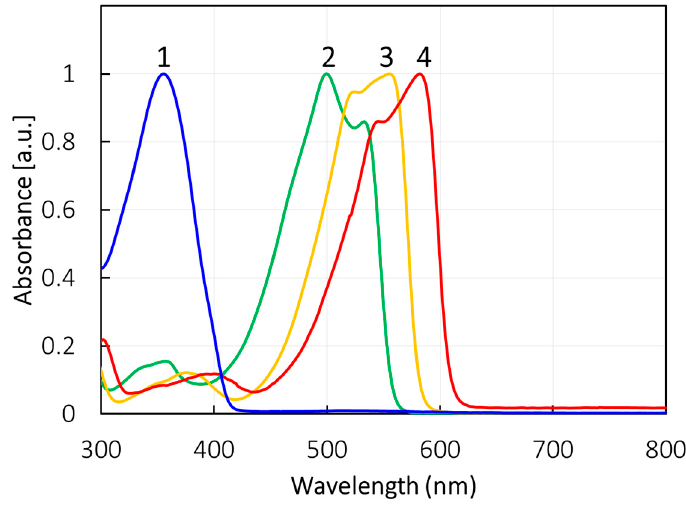
Figure 4. Absorption spectra of 1 – 4 in dichloromethane. The absorption spectra were normalized at the maxima.